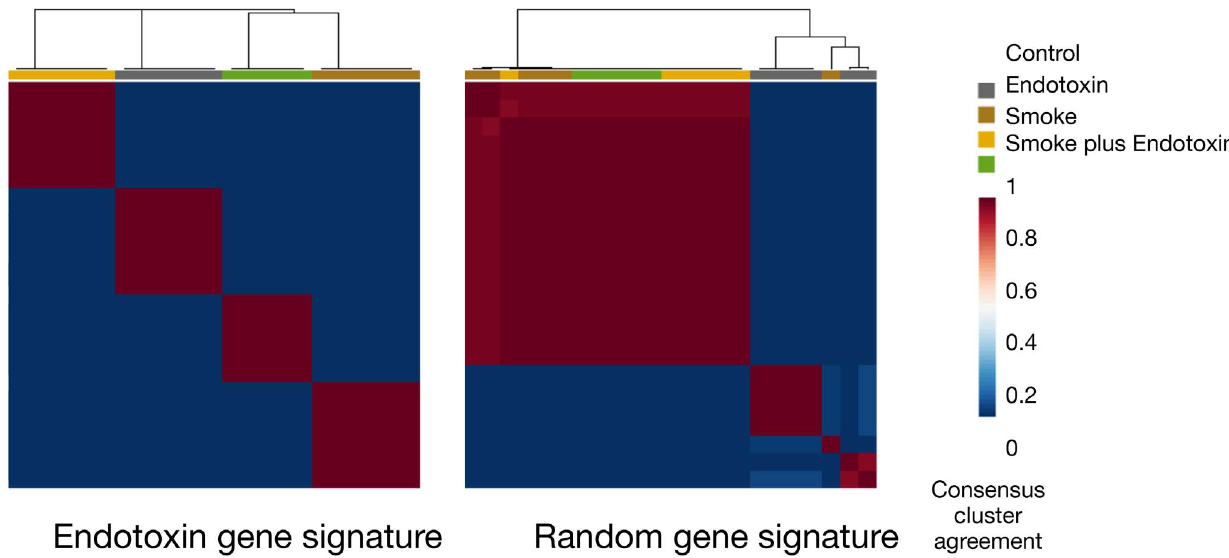
Figure 3. Consensus clustering of air, endotoxin, smoke, and endotoxin plus smoke exposed mice using endotoxin gene signature and random gene signature. The endotoxin gene signature accurately clusters the different exposure groups 99.97% of the time as compared to a randomly chosen gene signature which accurately clusters the different exposure groups 78.15% of the time.